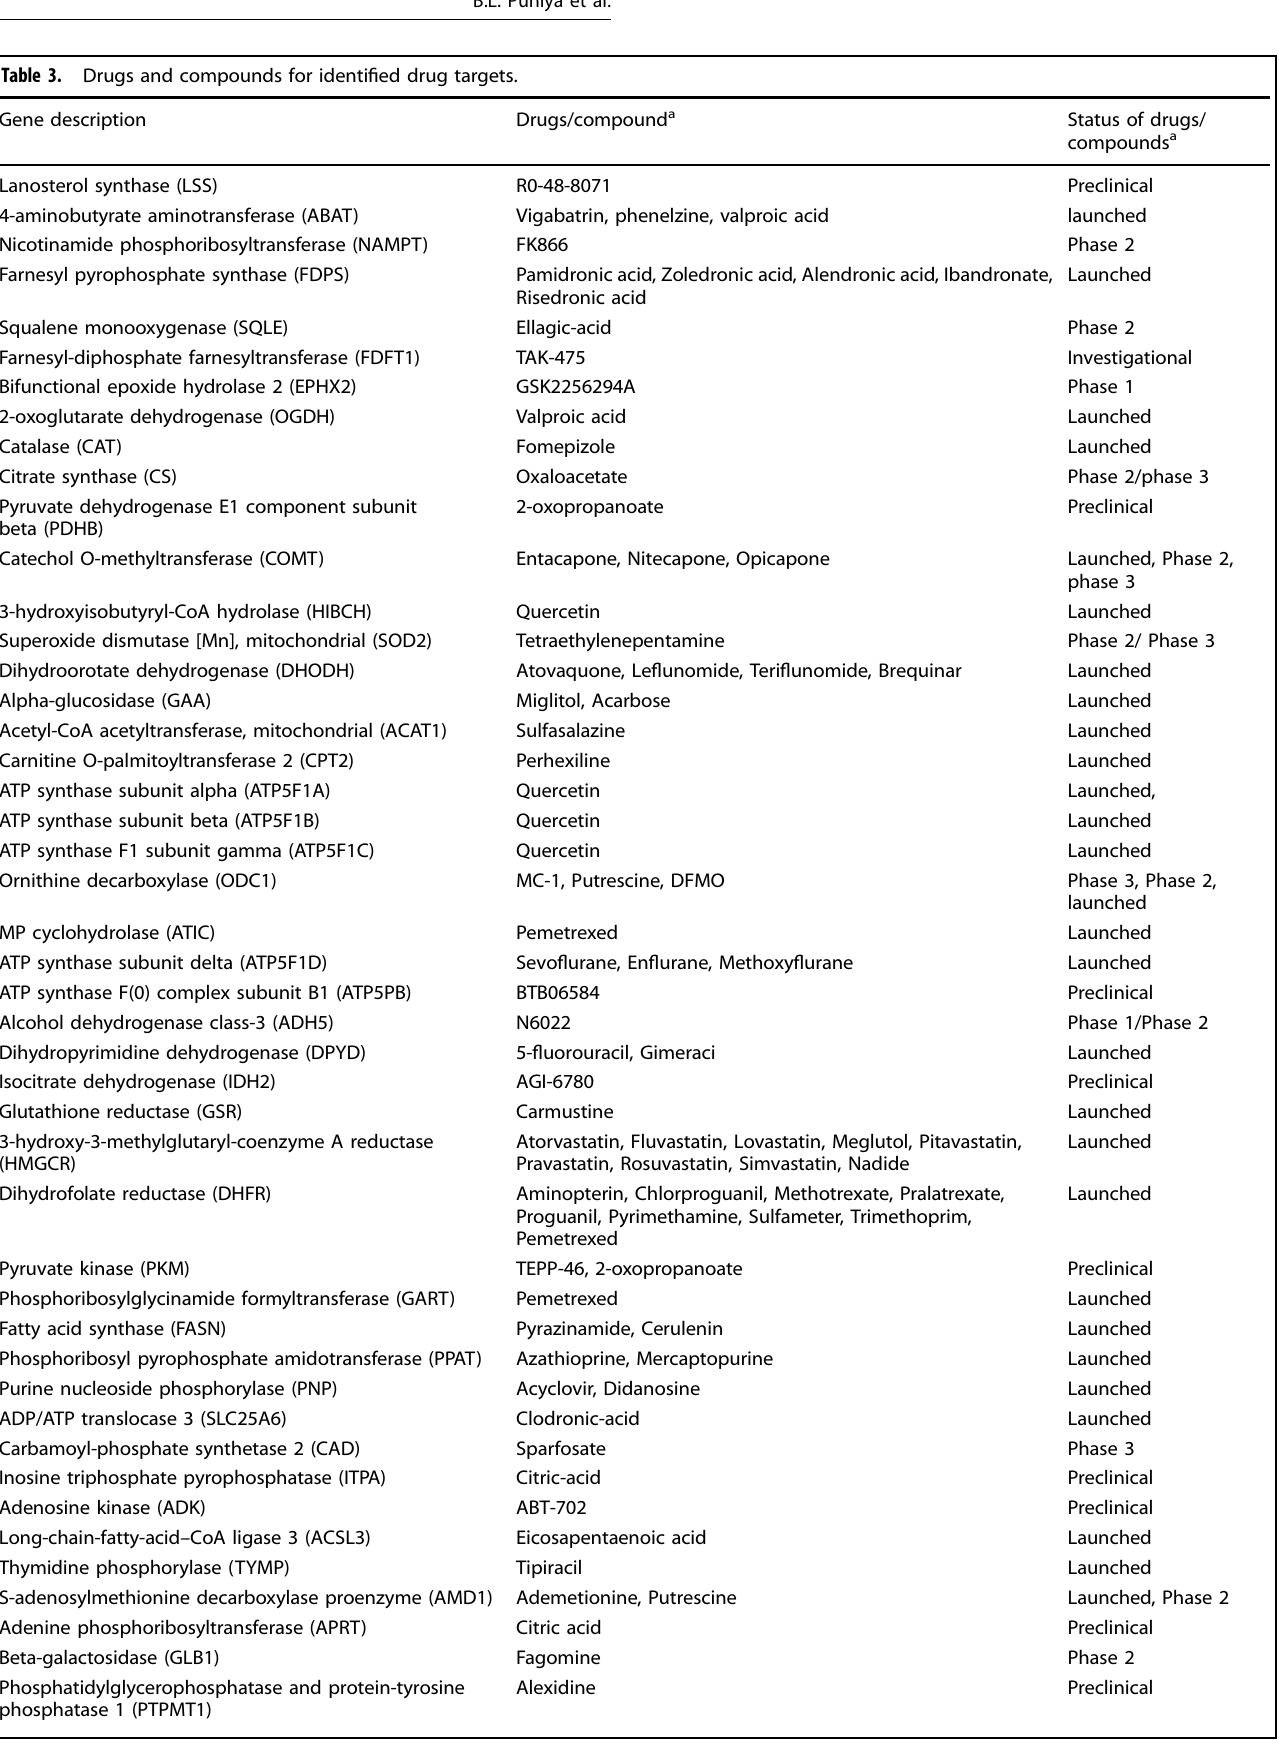
Table 3. Drugs and compounds for identi fi ed drug